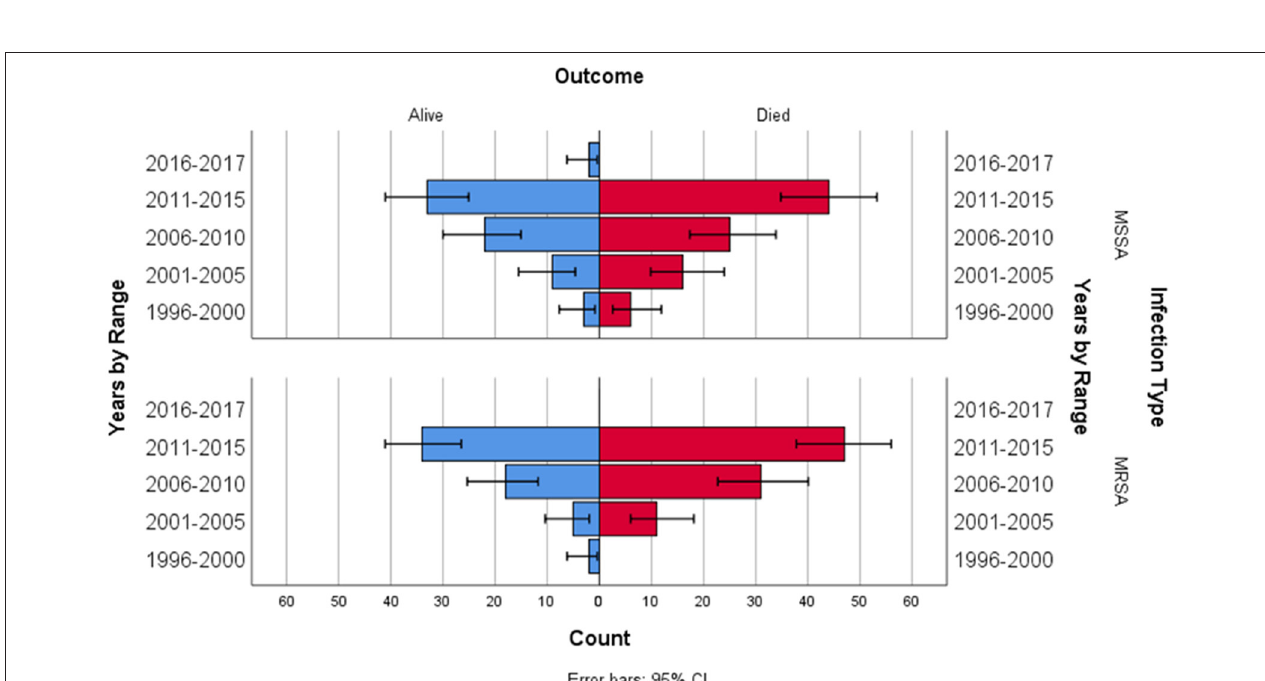
FIGURE 2 | Outcome by year and infection